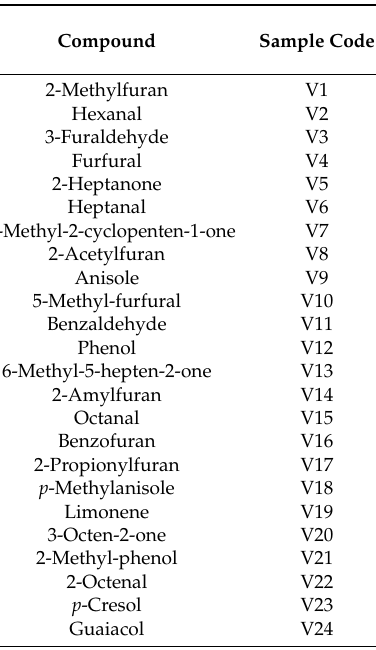
Table 2. Identification of volatile compounds, by GC-MS, in smoked and non-smoked Iranian